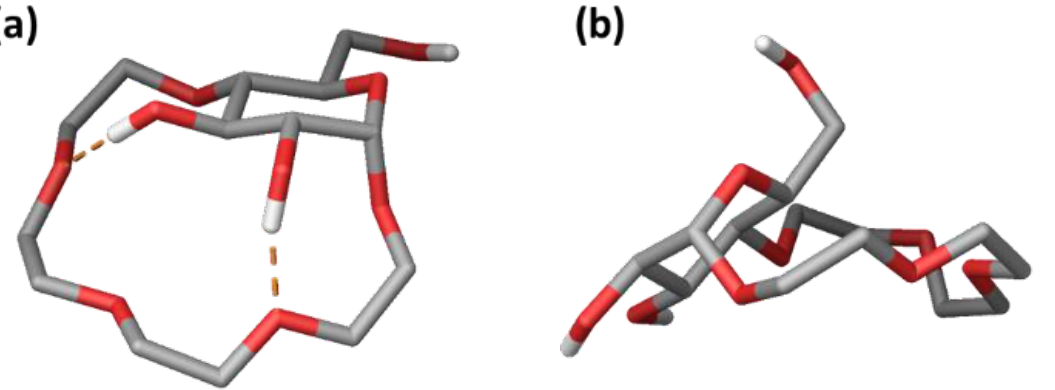
Figure 4. Lowest energy conformation of 1 obtained with MacroModel using: ( a ) CHCl 3 and ( b ) D 2 O as implicit solvent models.